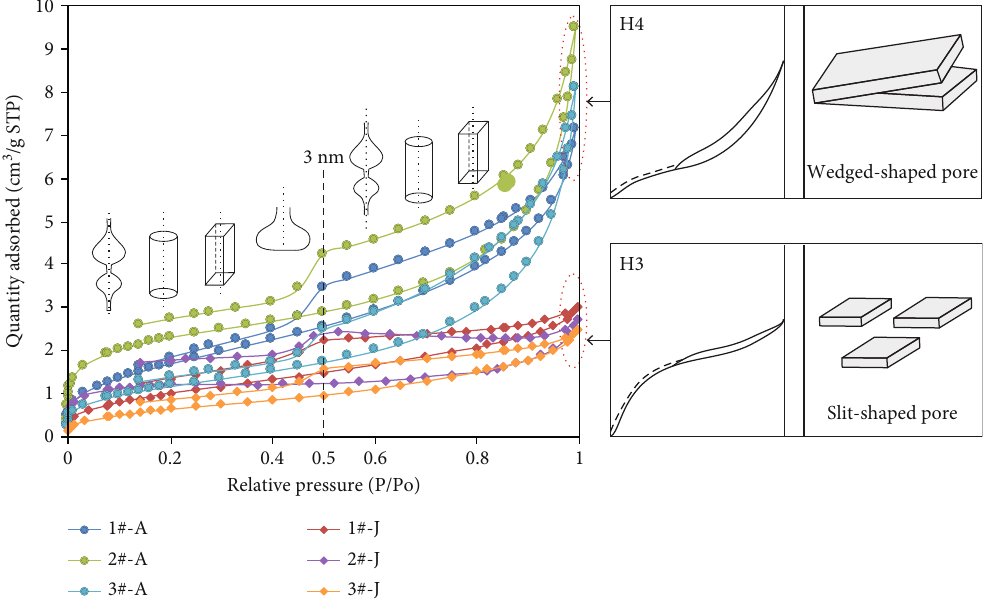
Figure 4: Ad/desorption isotherms of the N